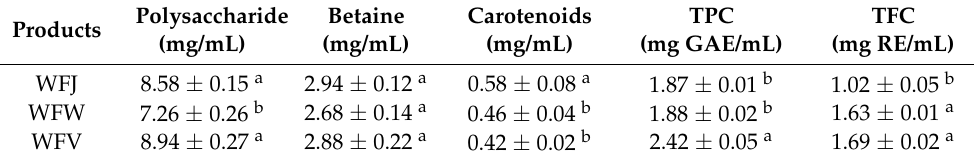
Table 4. Contents of nutrients of wolfberry fruit vinegar in the fermentation